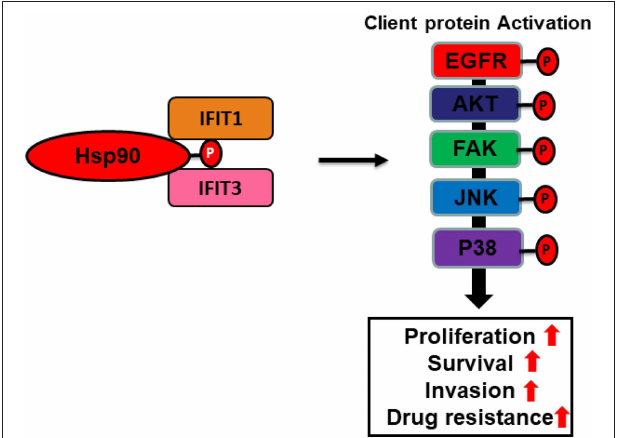
FIGURE 4 | Cartoon illustration depicting putative co-chaperone functions of IFIT1 and IFIT3. A hypothetic scheme shows that IFIT1/IFIT3 may regulate C-terminal phosphorylation of Hsp90 and hence enhance proper folding and maturation of its downstream signaling regulators in OSCC.